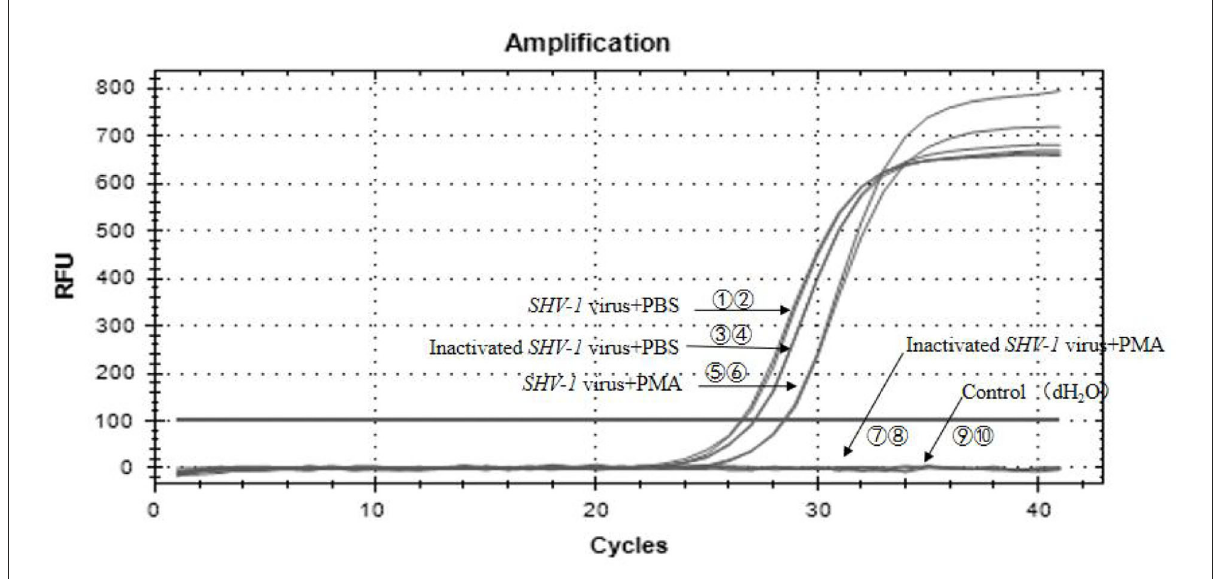
FIGURE6 PMA-qPCR of infectious SHV-1 virus. ‹ , › The SHV-1 virus + PBS group (sample no. 47); fi , fl the inactivated virus + PBS group (sample no. 65); (cid:176) , – the SHV-1 virus + PMA group (sample no. 6); † , ‡ the inactivated virus + PMA group (sample no. 51); · , (cid:181) the control group (dH